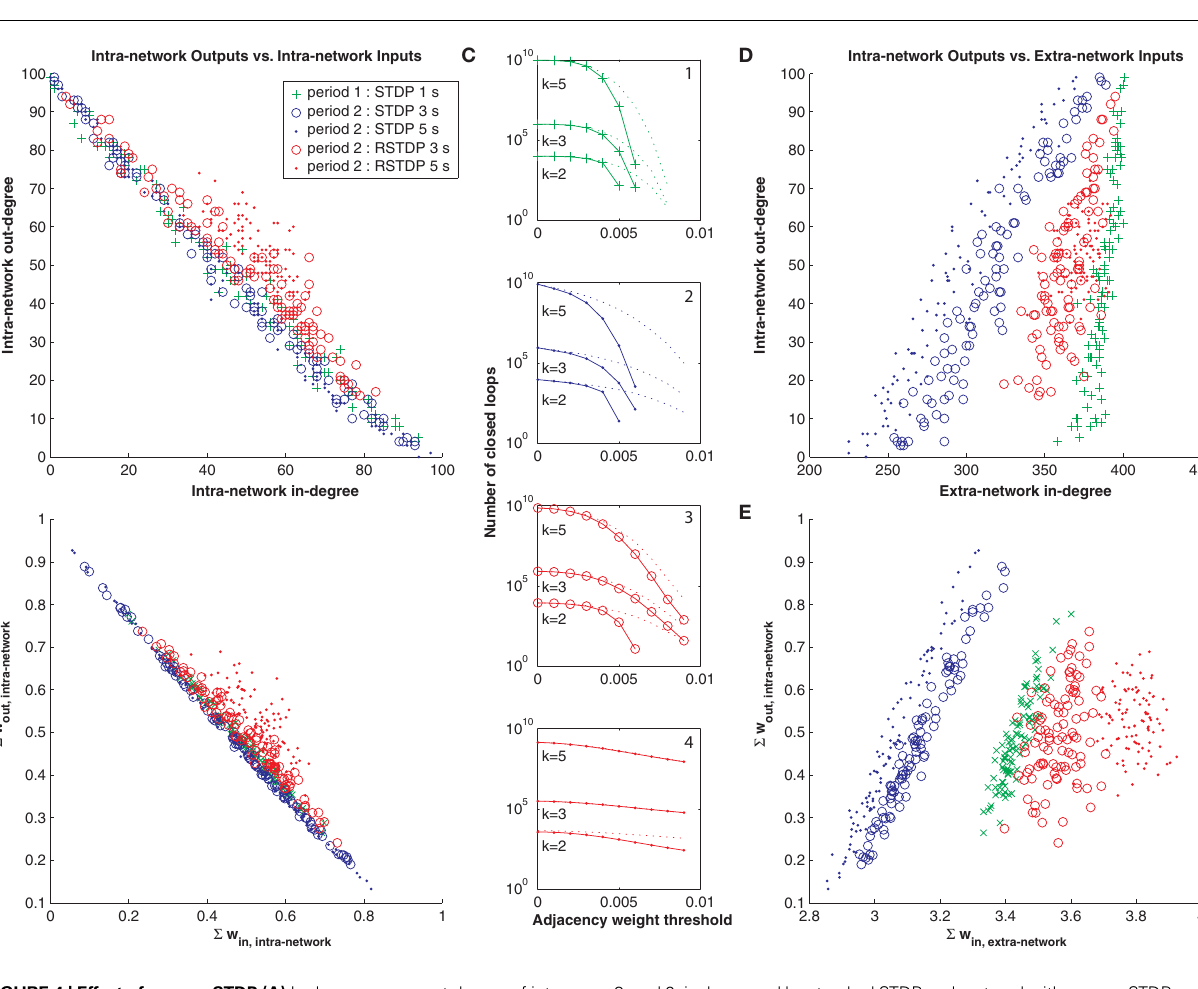
3, and 2, is decreased by standard STDP, and restored with reverse STDP (plotted as in Figure 2B ). (D) In-degree of extra-network inputs versus out- degree of intra-network outputs, plotted as in (A) , shows a strong positive correlation for standard STDP. Adjacency weight threshold was 0.007 for extra- network inputs and 0.005 for intra-network outputs. (E) Total synaptic extra- network input versus total synaptic intra-network output, plotted as in (B) , shows a similar positive correlation. In each panel the topological effects of STDP are reversed by reverse